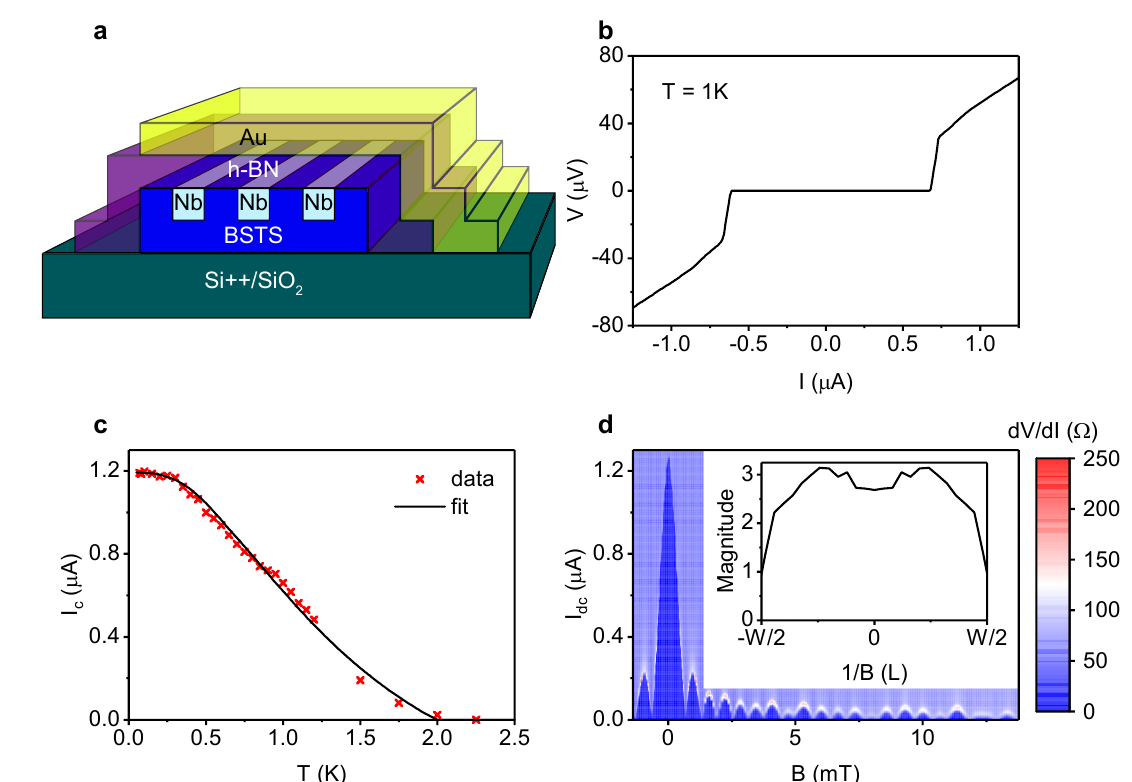
Figure 1. ( a ) Schematic image of a typical device. A BiSbTeSe 2 flake was contacted with parallel Nb leads designed to create Josephson junctions in the BiSbTeSe 2 . The leads were equipped with contact pads at both ends to allow for pseudo four-wire measurements. An h-BN flake and a Au contact on top of the BiSbTeSe 2 flake form a top gate structure. ( b ) IV -curve of junction 1a, one of the junctions of device 1, at 1 K. The critical current and the re-trapping current are similar. ( c ) Critical current as function of temperature for junction 1a. The fit with the clean limit Eilenberger equations suggests that the junction is in the ballistic regime. ( d ) Fraunhofer pattern of junction 1a. The supercurrent maximum at non-zero field indicates the presence of a small stray field. The Fourier transform in the inset shows a moderately homogeneous current distribution through the junction, except for a reduction at the edges of the